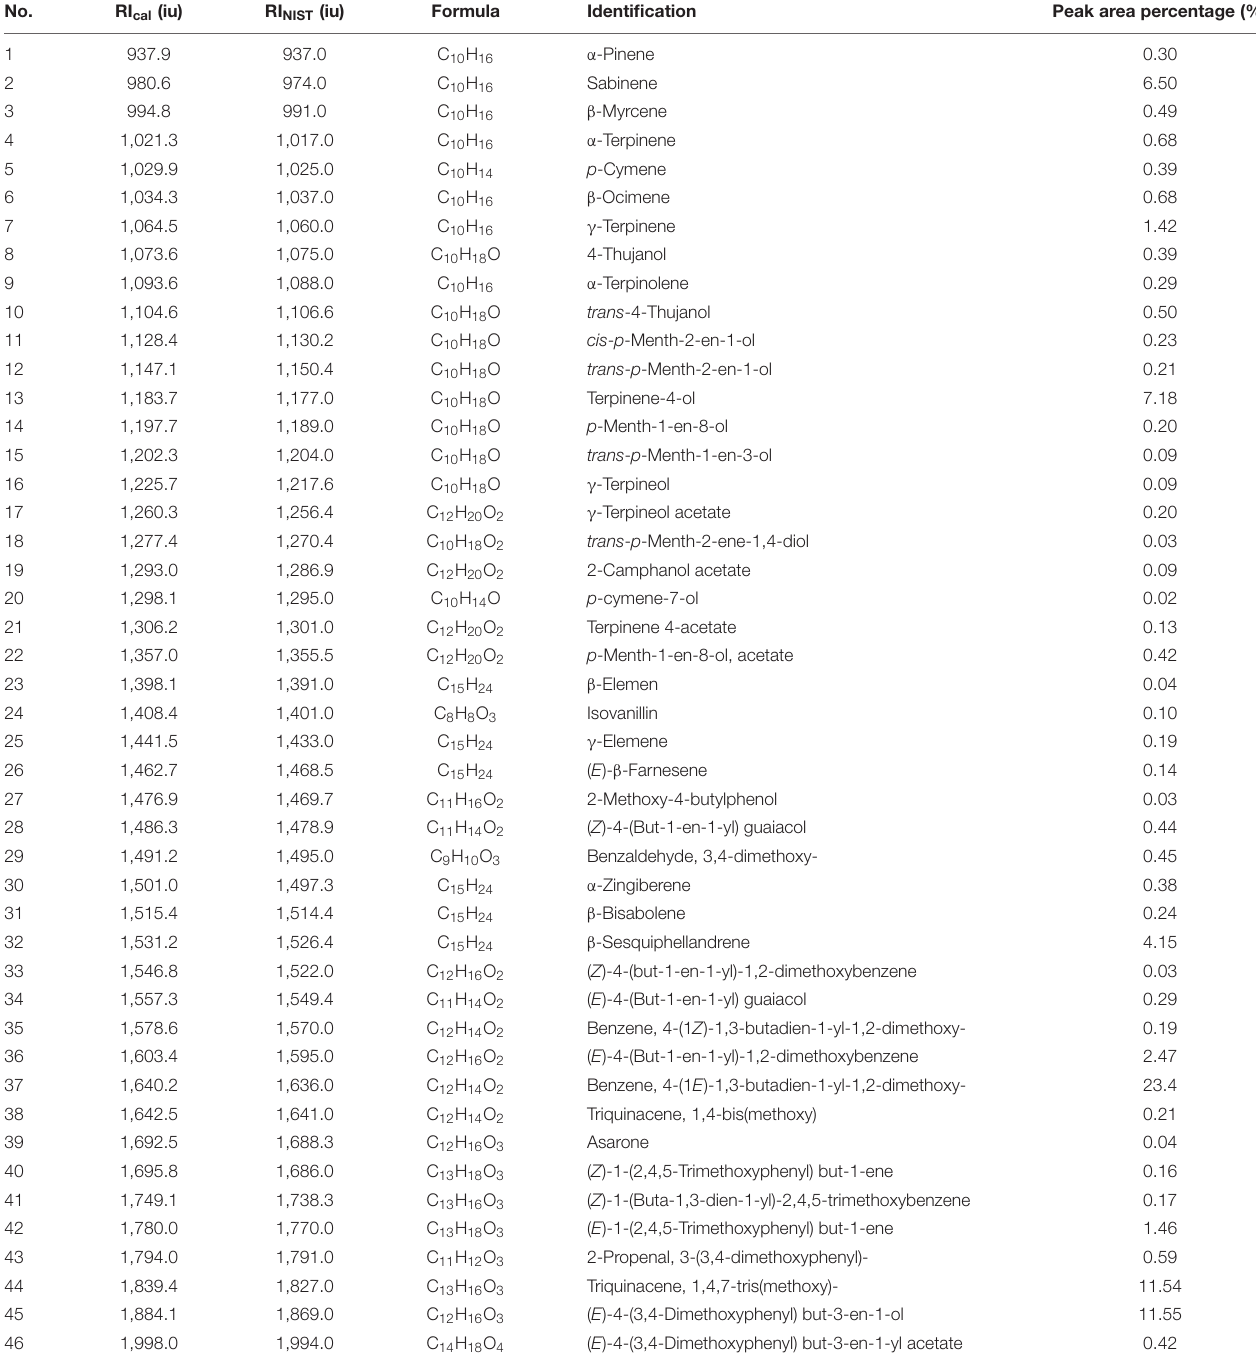
TABLE 4 | The Characterization of volatile oil ingredients in Z. corallinum by gas chromatography-mass spectrometry (GC-MS). No. RI cal